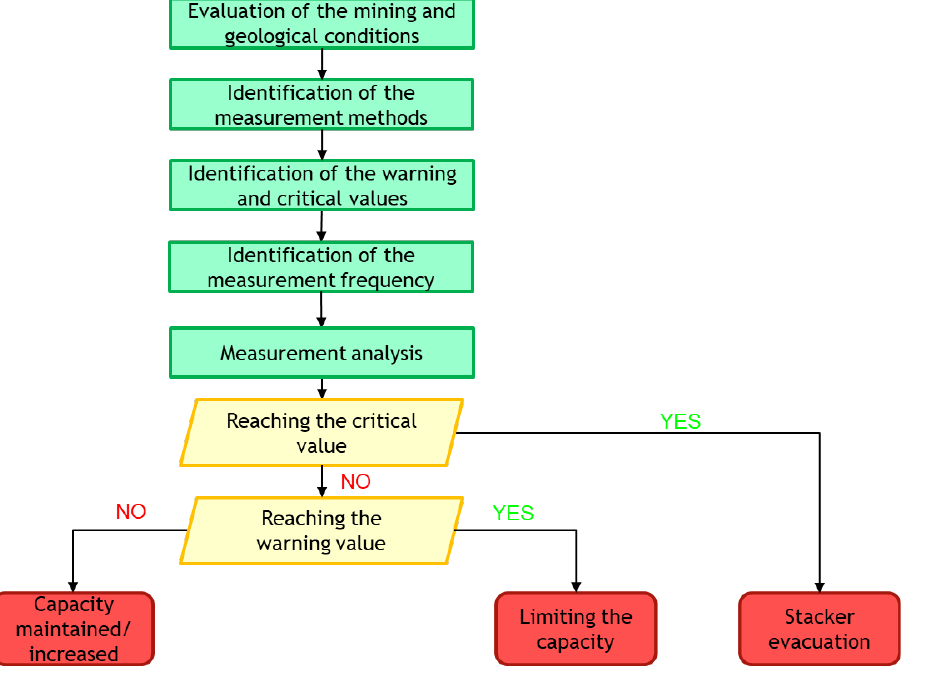
Figure 1: The procedure of the observation method for the control of stacker capacity.